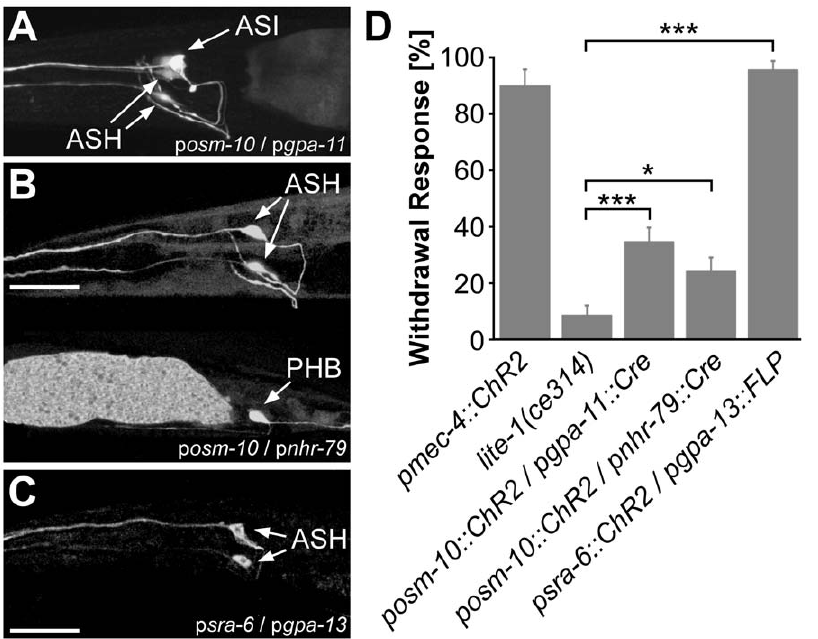
Figure 3. Expression pattern and behavioral responses of animals generated towards ChR2 expression in ASH by using Cre recombinase. GFP fluorescence (confocal stacks) in animals expressing ChR2::mCherry and GFP (bicistronically co-expressed) using the promoter combinations osm-10 and gpa-11 A ), osm-10 and nhr-79 B ), or sra-6 and gpa-13 C ). Scale bar=20 m m. D ) Behavioral assay testing withdrawal reactions in response to 470 nm blue light illumination of the indicated conditional expression strains (all lite-1(ce314) background). Strain AQ2334 (pmec-4::ChR2) and lite-1(ce314) were used as positive and negative controls, respectively. n=14 animals of each strain were tested, with 5 consecutive light pulses each; displayed are means 6 SEM. Stastistically significant differences were determined by t-test, relative to the lite-1(ce314) control. * p , 0.05; *** p , 0.001.